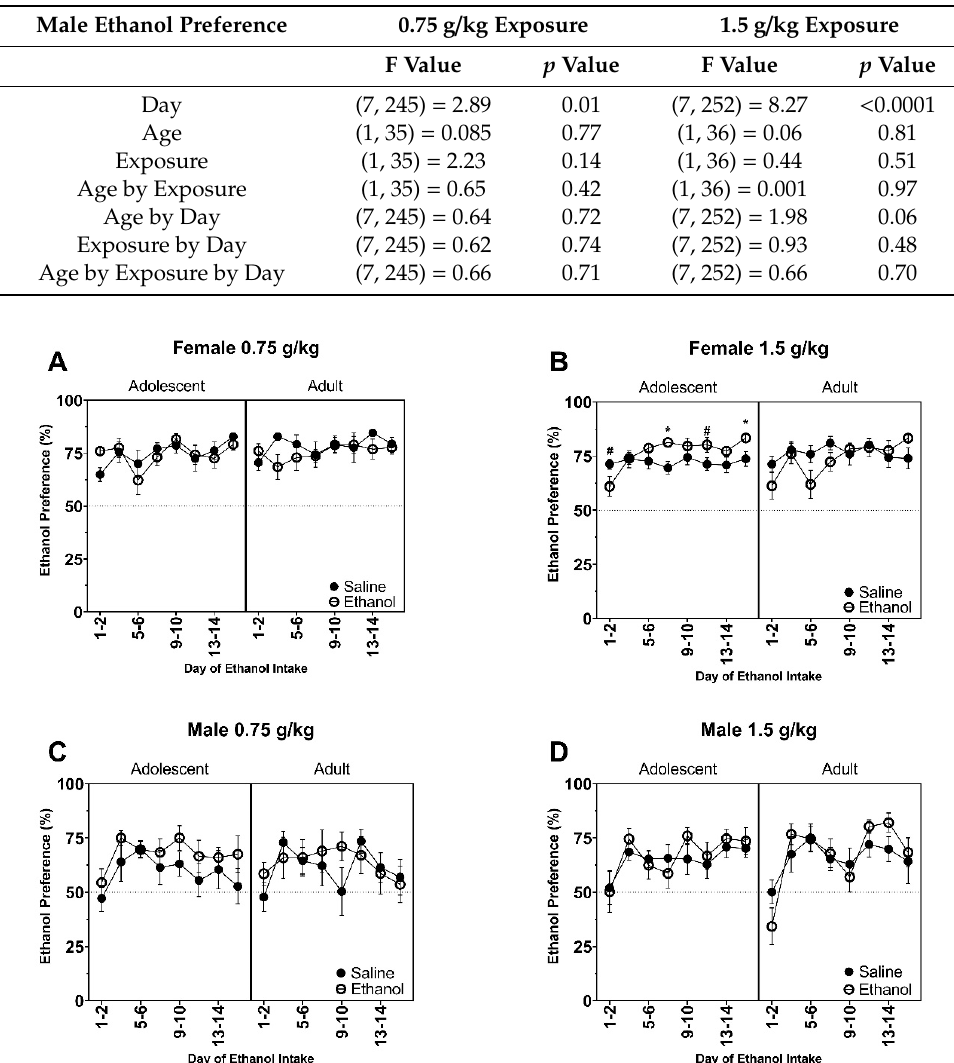
Figure 3. Data are presented as preference for ethanol ((ethanol (mL) / ethanol + water (mL)) × 100) for the 30 min session. Female rats chronically exposed to ( A ) 0.75 g / kg and ( B ) 1.5 g / kg. Male rats chronically exposed to ( C ) 0.75 g / kg and ( D ) 1.5 g / kg. * indicates ethanol-exposed significantly greater than ethanol-exposed. # indicates p = 0.06 for ethanol-exposed rats to have increased ethanol preference compared to saline-exposed rats.